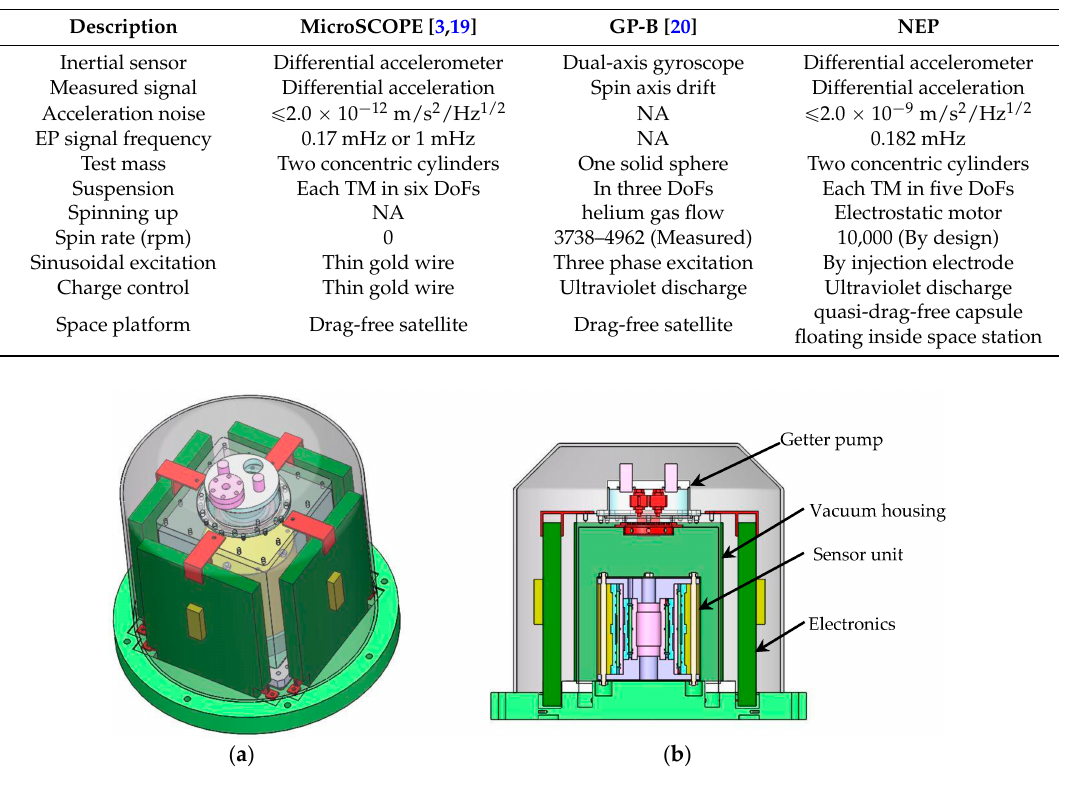
Figure 2. NEP instrument: ( a ) Mechanical sensor core mounted in a tight housing with above the vacuum system and surrounding the suspension and rotation control units; ( b ) Cross-sectional view of the differential accelerometer including two concentric test masses.